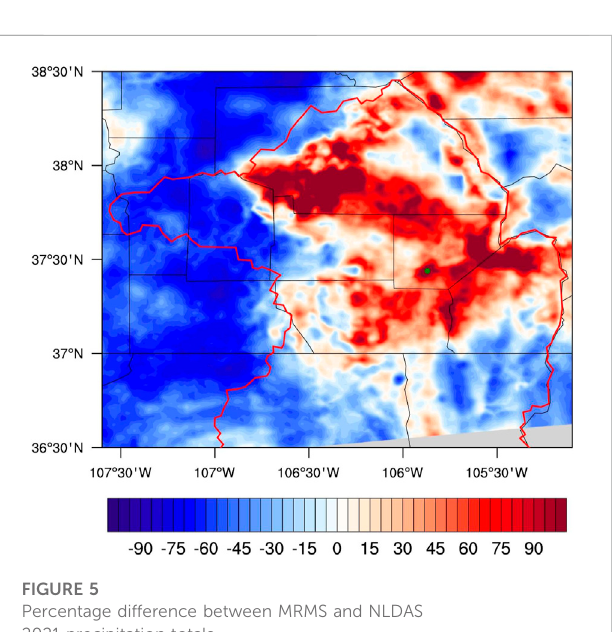
FIGURE 4 Same as Figure 2, except MRMS 2021 precipitation totals are shaded.